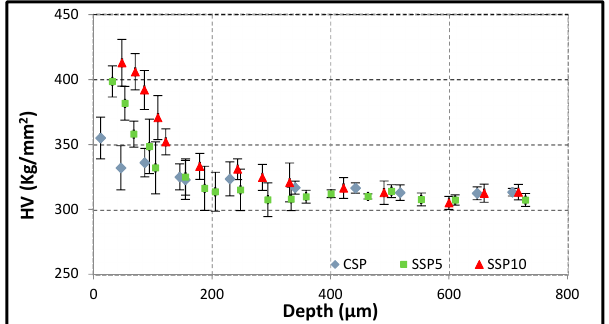
Figure 4. Microhardness trend of CSP, SSP5, and SSP10 samples.